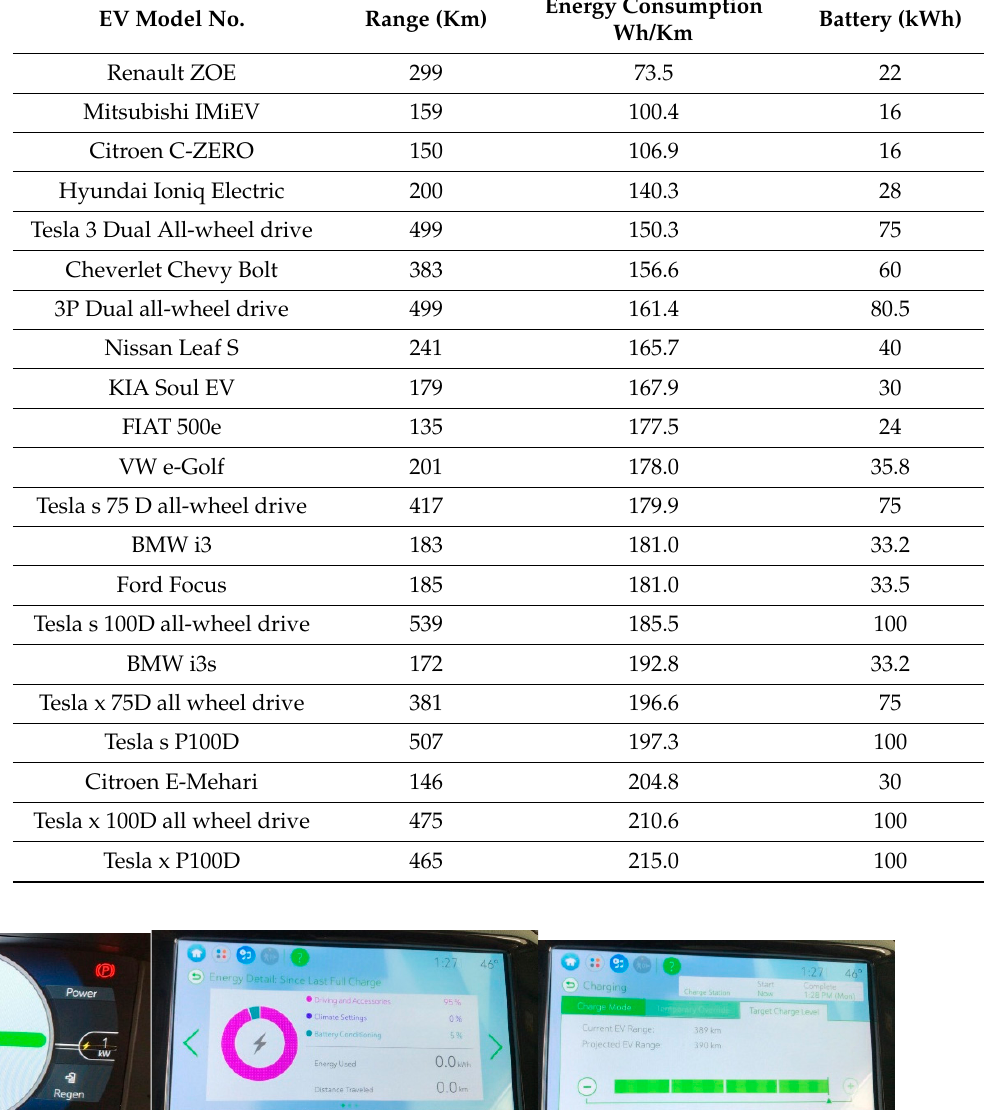
Table 1. Some of the electric vehicles available in the market [12]. EV Model No.